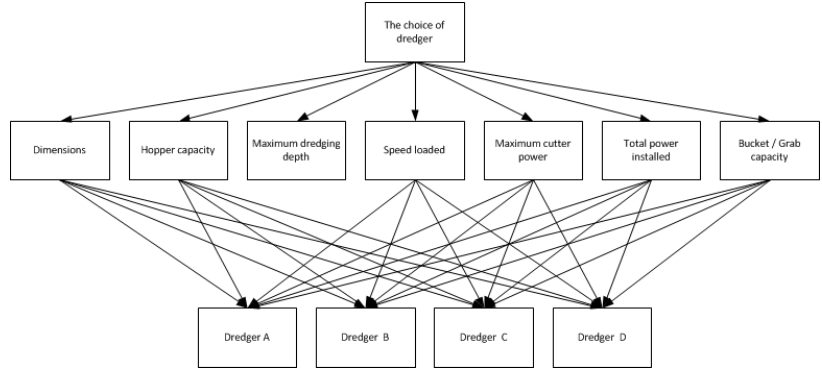
Figure 6. Chart of the hierarchy of the dredger selection using the AHP method.